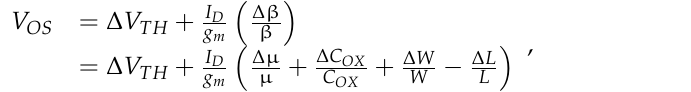
Figure 2. Block diagram of the proposed ROIC.